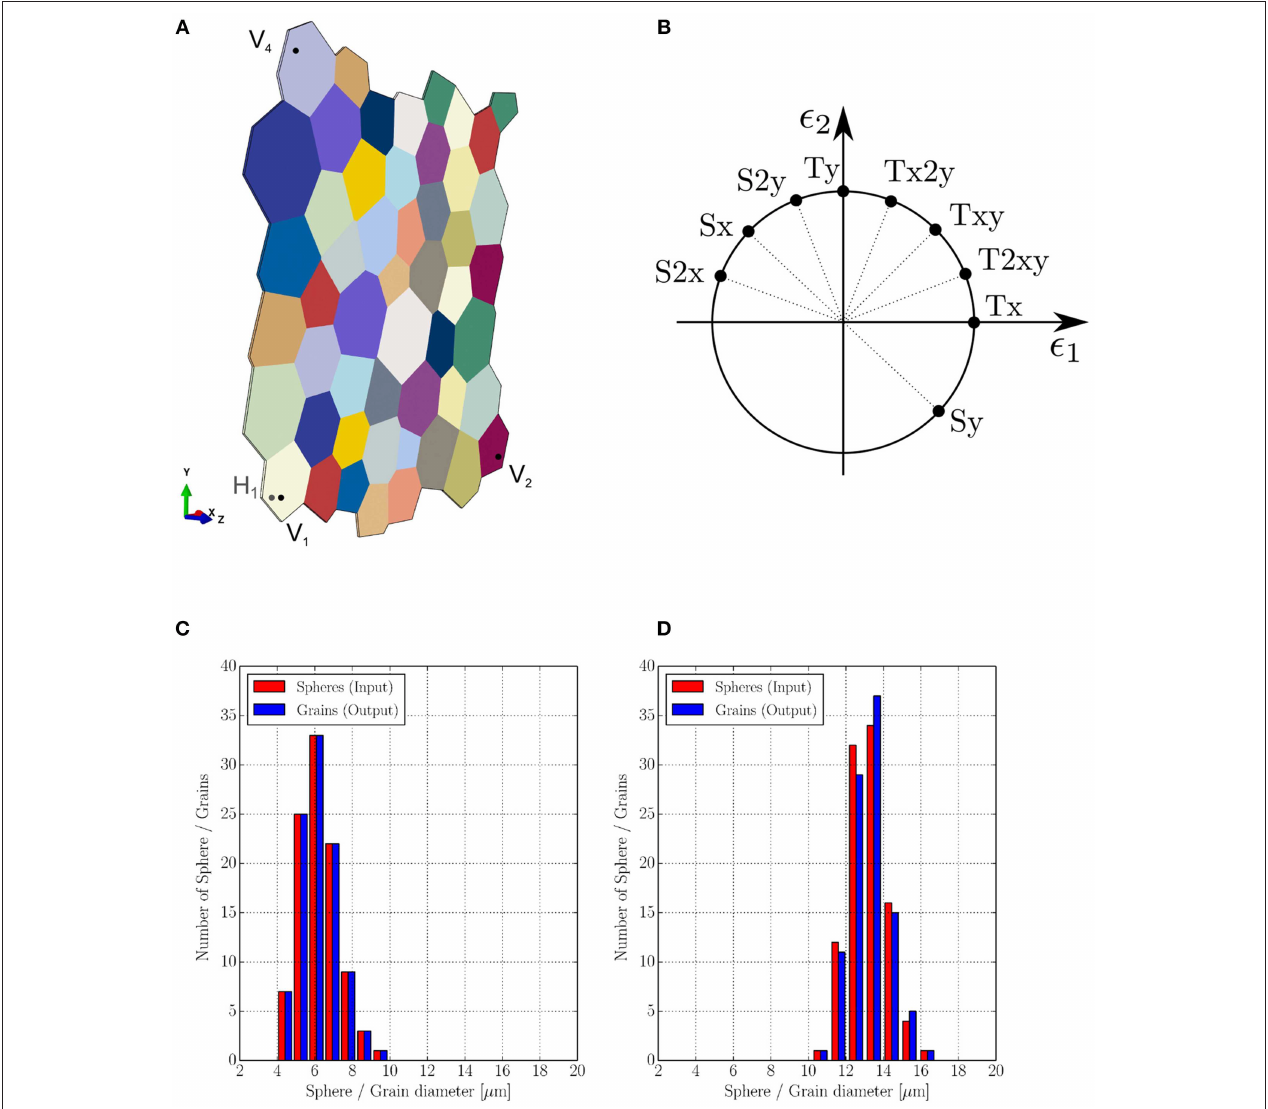
FIGURE 1 | (A) Quasi-2D RVE with vertex nodes ( V 1 , V 2 , V 4 , H 1 ) needed for the boundary conditions (see section 2.3.3); RVE with a mean grain size of 59 µ m and a standard deviation of 10 µ m contains 51 grains between 40 and 90 µ m, has a side length of 348.8 µ m and a thickness of 1.7 µ m and is used as model for the damage evolution (cf. section 4). (B) Loading cases applied to the RVE used for the prediction the damage evolution in section 4. Comparisons of diameter distribution between defined spheres and constructed RVEs with (C) average grain size µ of 6.0 µ m and standard deviation σ of 1.0 µ m, and (D) average grain size µ of 13.0 µ m and standard deviation σ of 1.0 µ